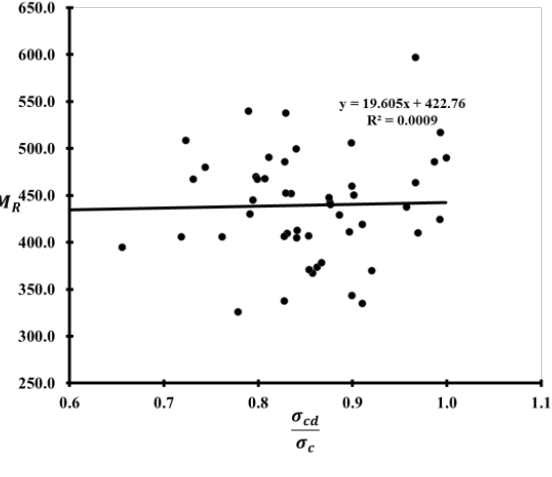
Fig. 14. Relationship between and Fig. 15. Relationship between M Figure 14: Relationship between R M and cd Fig. 16. Relationship between 𝜎𝜎 𝑐𝑐𝑐𝑐 𝑀𝑀 𝑅𝑅 𝜎𝜎 𝑐𝑐 6 Fig. 16. Relationship between 𝜎𝜎 𝑐𝑐𝑐𝑐 𝜎𝜎 𝑐𝑐 and 𝜀𝜀 𝑎𝑎 (cid:3) 𝑚𝑚𝑎𝑎𝑚𝑚 𝜀𝜀 𝑐𝑐𝑐𝑐 Fig .17. Relationship between 𝑀𝑀 𝑅𝑅 and crack initiation stress( 𝜎𝜎 𝑐𝑐𝑐𝑐 )